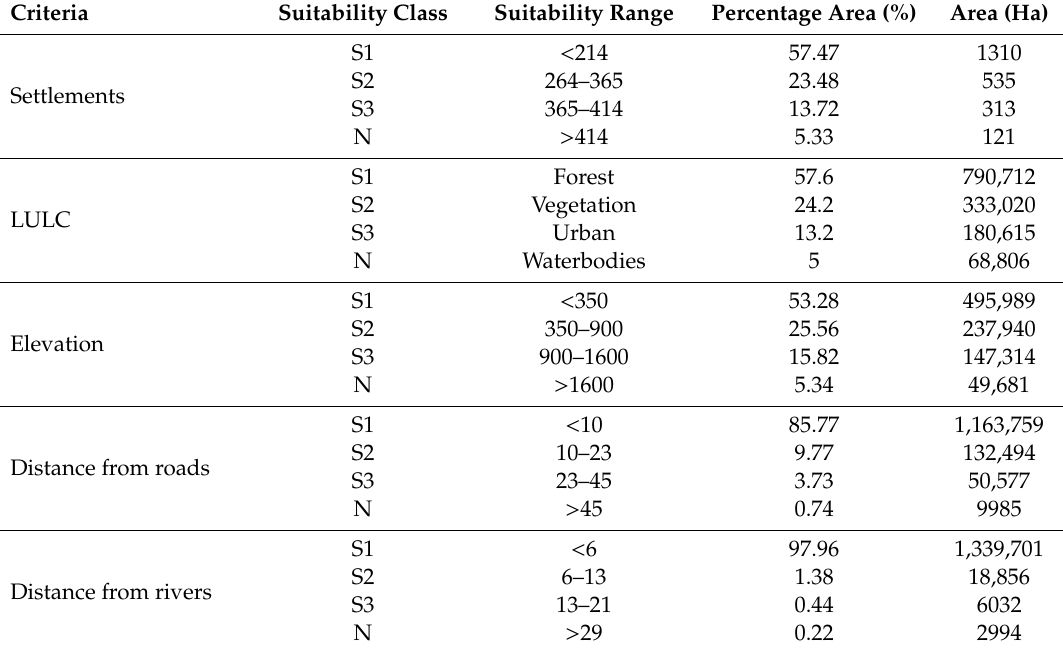
Table 4. Reclassification of the criteria of land suitability for forest extension